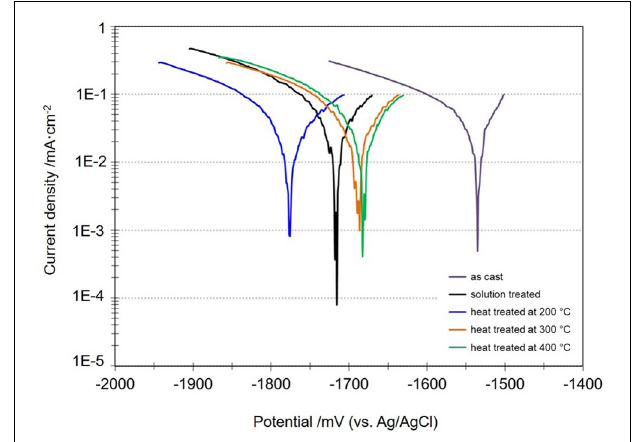
FIGURE 4 | Open circuit potentials of Mg-10Gd alloy in as-cast, solution treated, heat treated at 200 ◦ C, 300 ◦ C, and 400 ◦ C conditions in 0.5 wt.% NaCl solution for 30 min.